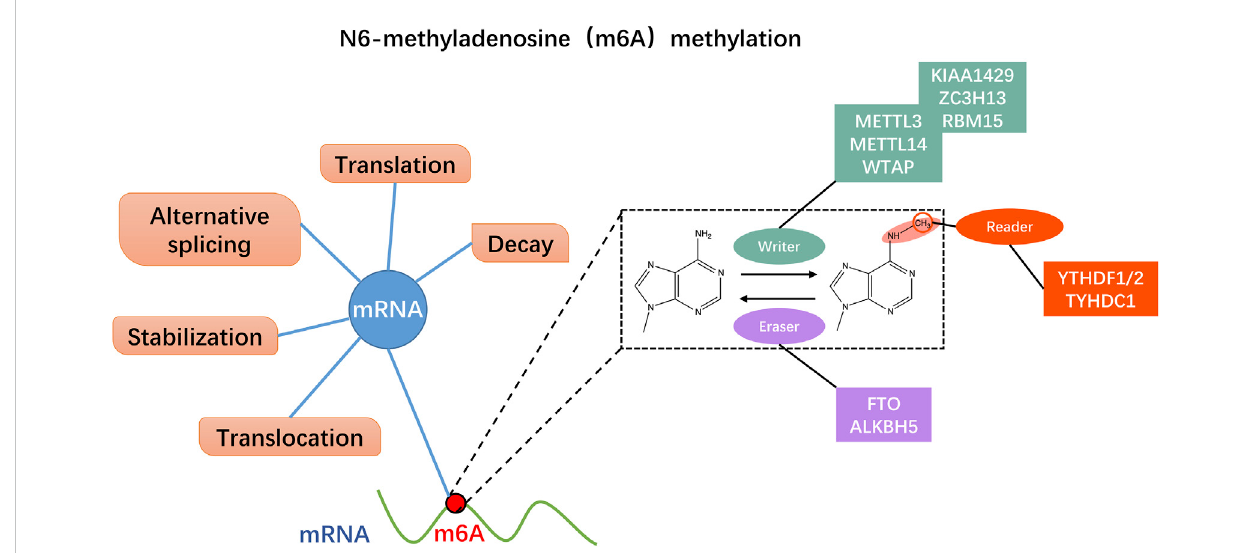
FIGURE 1 N6-methyladenosine (m6A) methylation dynamically regulates mRNA through multiple pathways. M6A regulatory proteins include m6A methyltransferases (m6A writers), m6A demethylases (m6A erasers), and m6A recognition proteins (m6A readers). The writers act as methyltransferase includingMettl3/14andWTAP.Theerasersmediatedemethylationmodi fi cations,likeFTPandALKBH5.M6AreadersrecognizeinformationaboutmRNA methylation and are involved in downstream mRNA translation, degradation, and other behaviors, such as YTHDF1/2 and